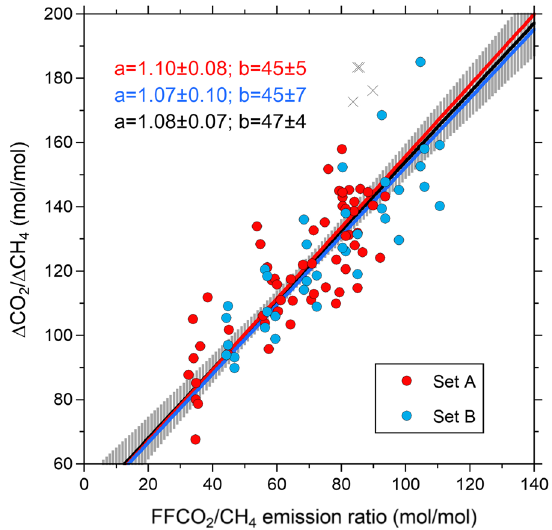
Fig. 6 Scatter plot between the FFCO 2 /CH 4 emission ratios in China and the simulated ΔCO 2 /ΔCH 4 ratios for HAT. The plots based on the FFCO 2 emissions of Set A and Set B are shown as red and blue circles, respectively. The red, blue, and black lines represent linear regression lines for the plots based on Set A, Set B, and their combined set, respectively. The values for “a” and “b” in the figure represent the related slopes and y-axis intercepts, respectively. The gray vertical bars are estimated uncertainties (1 σ ) for the regression line based on the total FFCO 2 data. Gray crosses are the outliers